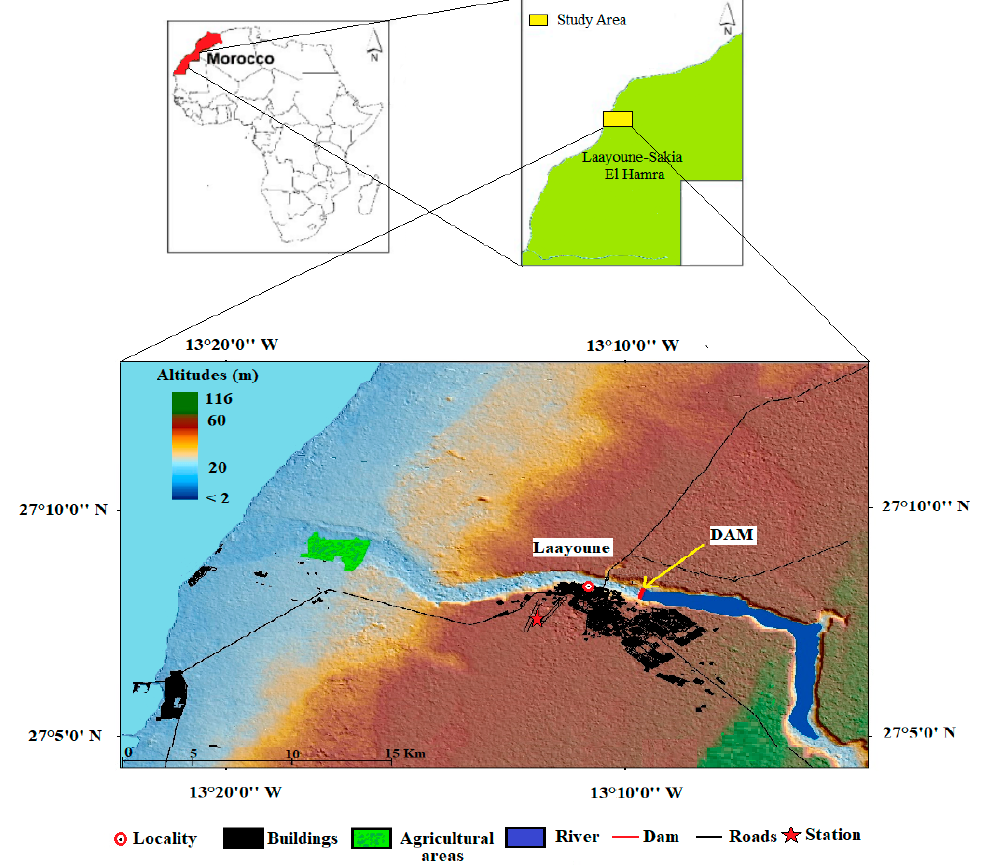
Figure 2. Location of the study area.